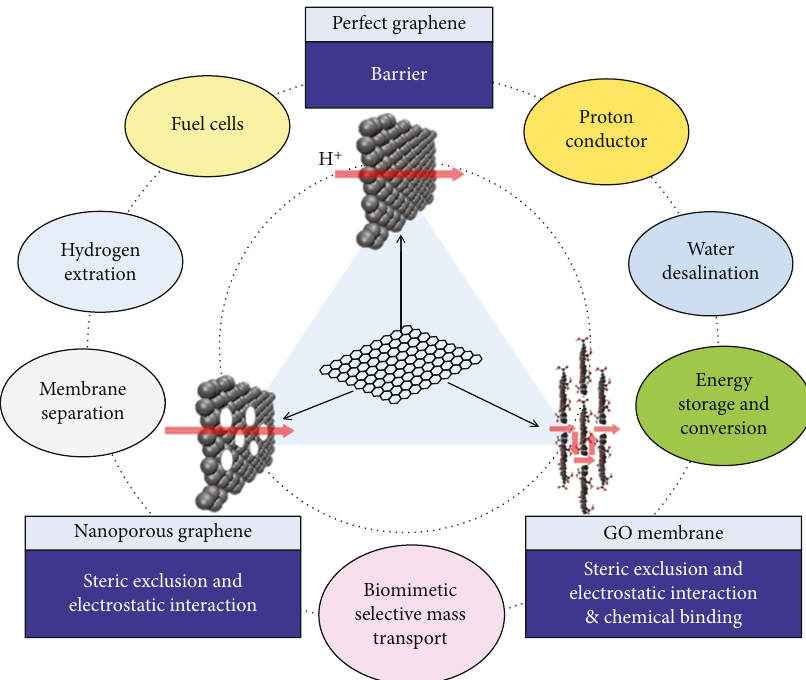
Figure 1: Applications and fi ltration mechanisms of graphene-based membranes. Reprinted with permission from [35]. Copyright John Wiley &